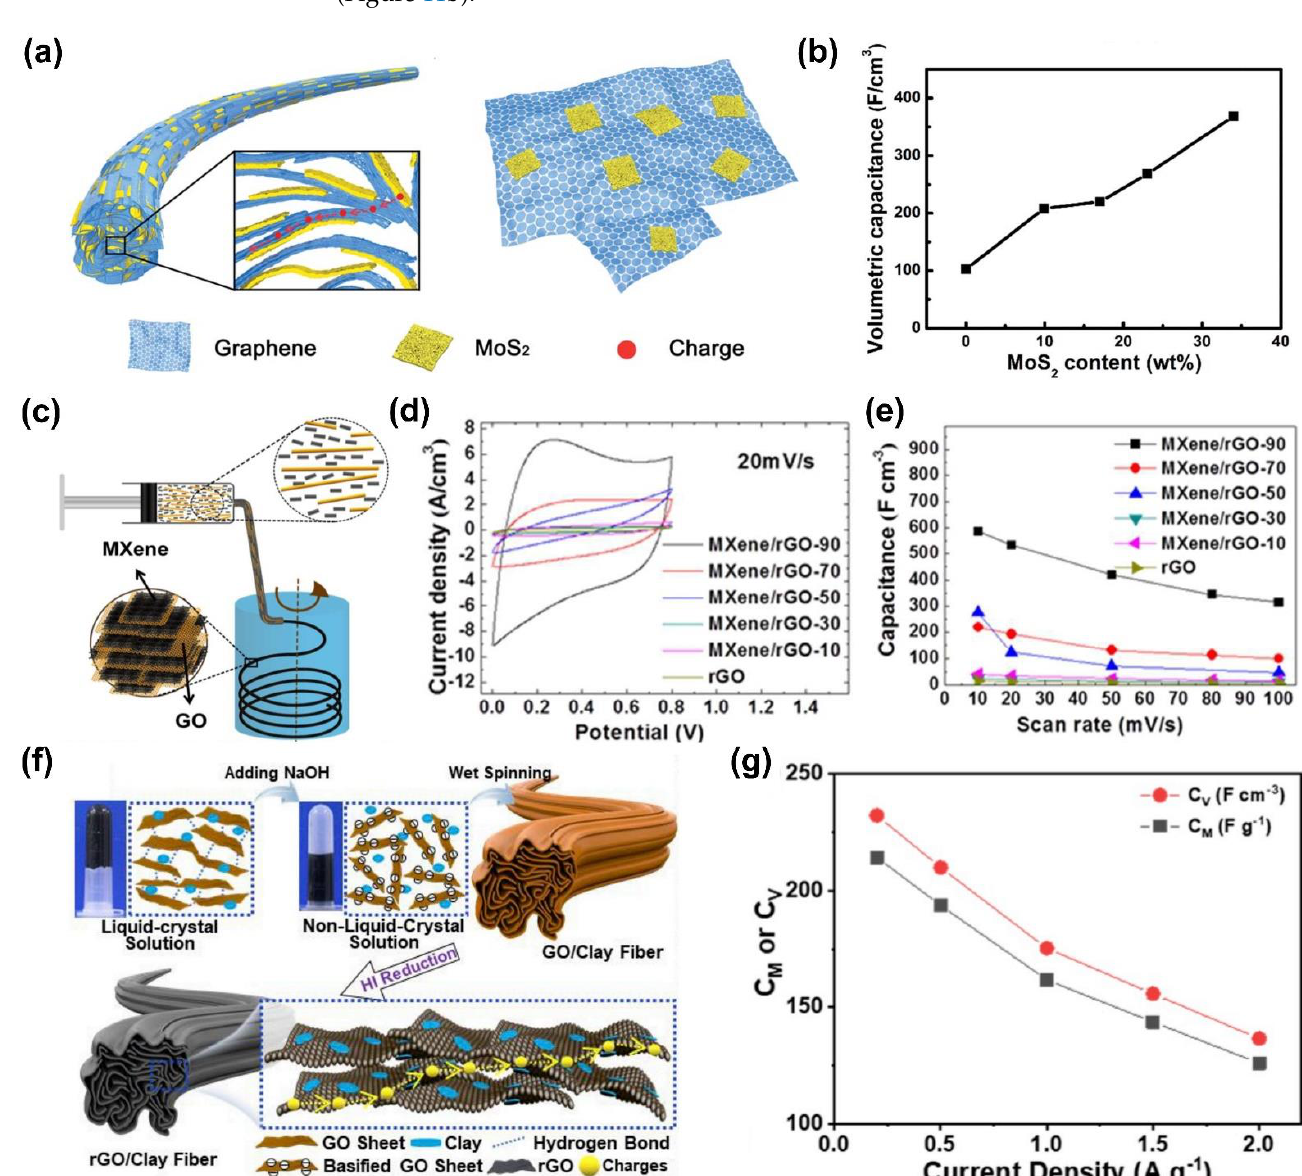
Figure 11. ( a ) Schematic illustration of the intercalated nanostructure of the graphene/MoS 2 hybrid fiber, where small MoS 2 sheets are epitaxially grown on large graphene sheets; ( b ) Dependence of volumetric capacitance on the MoS 2 content in the supercapacitor [105] (copyright permission The Royal Society of Chemistry 2017); ( c ) Schematic illustration of wet-spinning process for the MXene/GO fiber; ( d ) Current–voltage curves and ( e ) volumetric capacitances at different scan rates of the fabricated solid state MXene/rGO supercapacitors with various MXene contents [106] (copyright permission The Royal Society of Chemistry 2017); ( f ) Schematic illustration of the fabrication process of rGO/clay hybrid fibers; ( g ) Specific capacitance at different current density of rGO/clay fiber [74] (copyright permission Elsevier 2020).